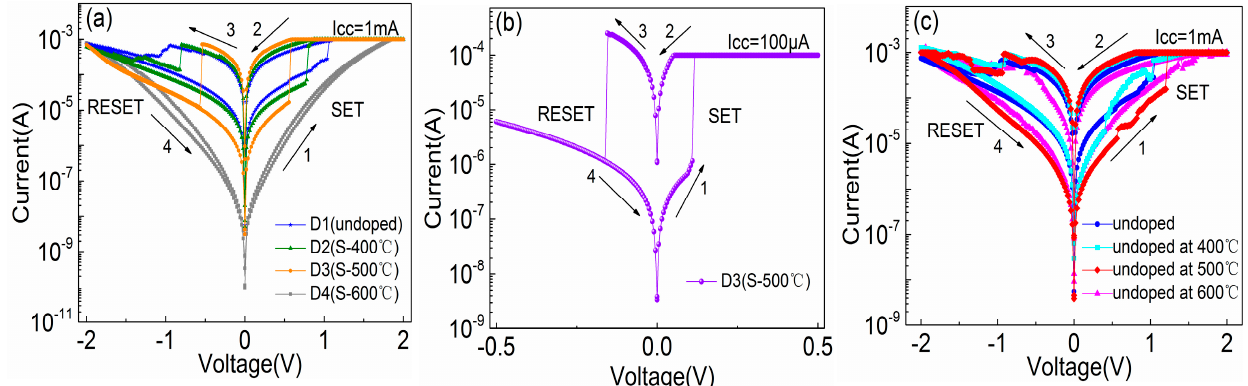
Figure 2. ( a ) Typical bipolar I–V cycles for DC sweep of the devices, ( b ) I–V cycle of D3 device under 100 μ A compliance